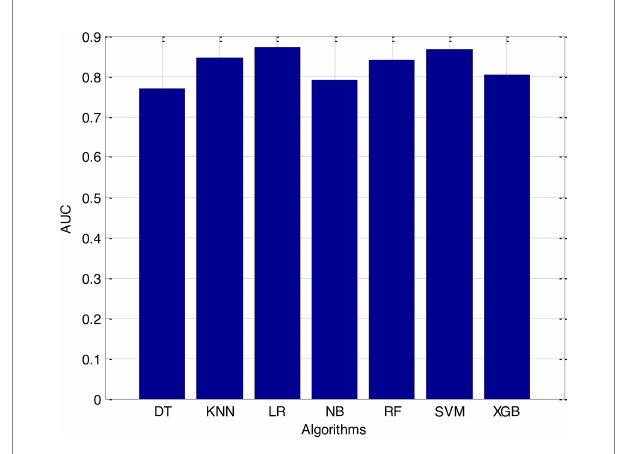
FIGURE 2 Area under the curve (AUC).